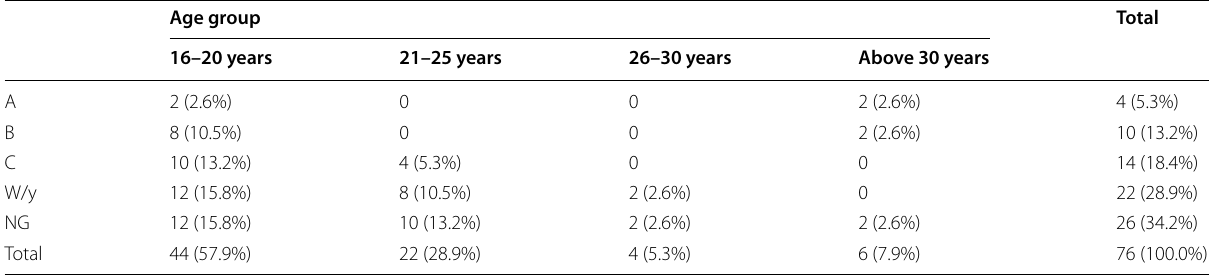
Table 2 Distribution of serogroups of Neisseria meningitidis isolate by age group among prisoners at correction facility in Jimma Town, Southwestern Ethiopia, 2019